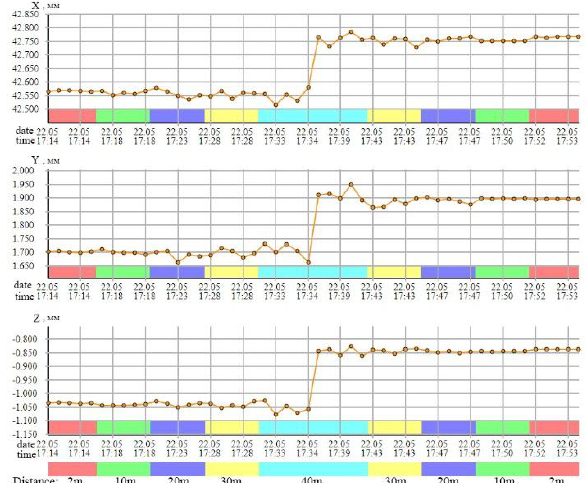
Figure 14. Relative X, Y and Z position graphs for the centers of two blocks of marks, determined by stereophotogrammetric method